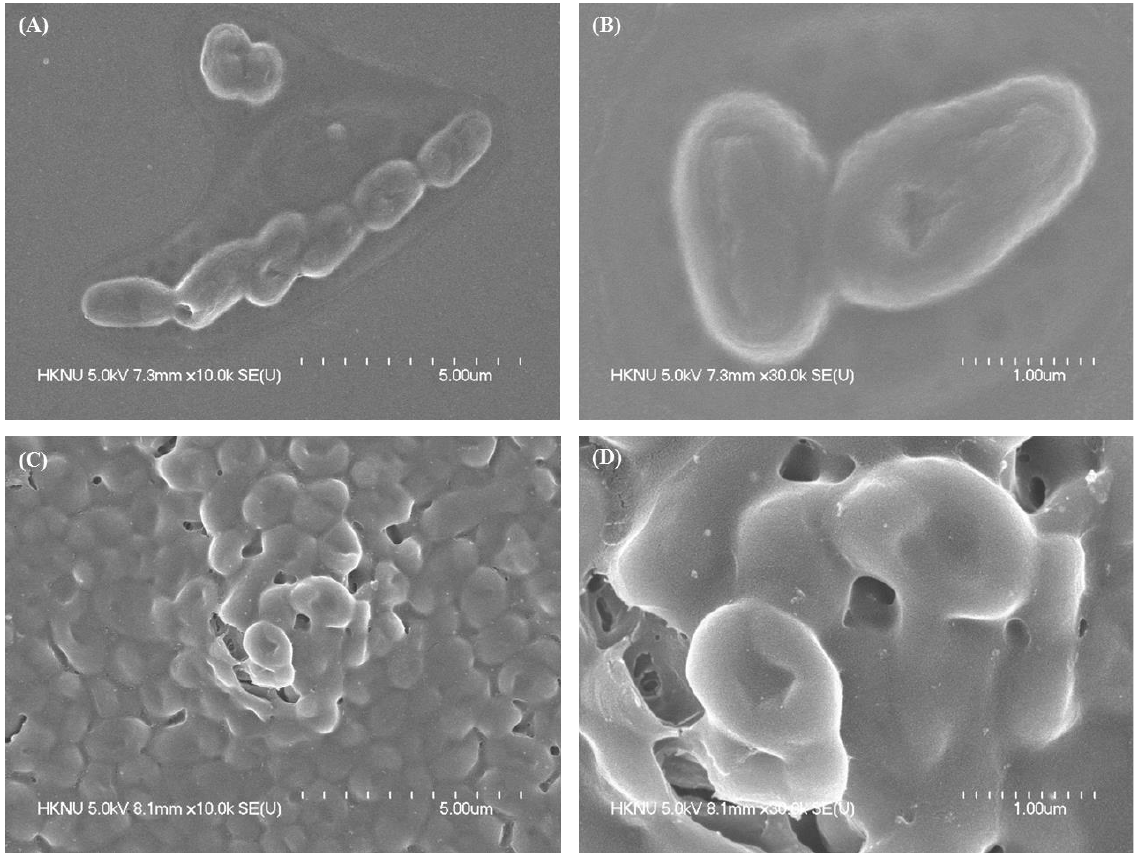
Figure 10. FE - SEM images of normal E. coli O157:H7 (ATCC 35150) ( A , B ) and 1 × MBC probiotic- mediated synthesized AgNPs treated E. coli O157:H7 (ATCC 35150) ( C , D ).